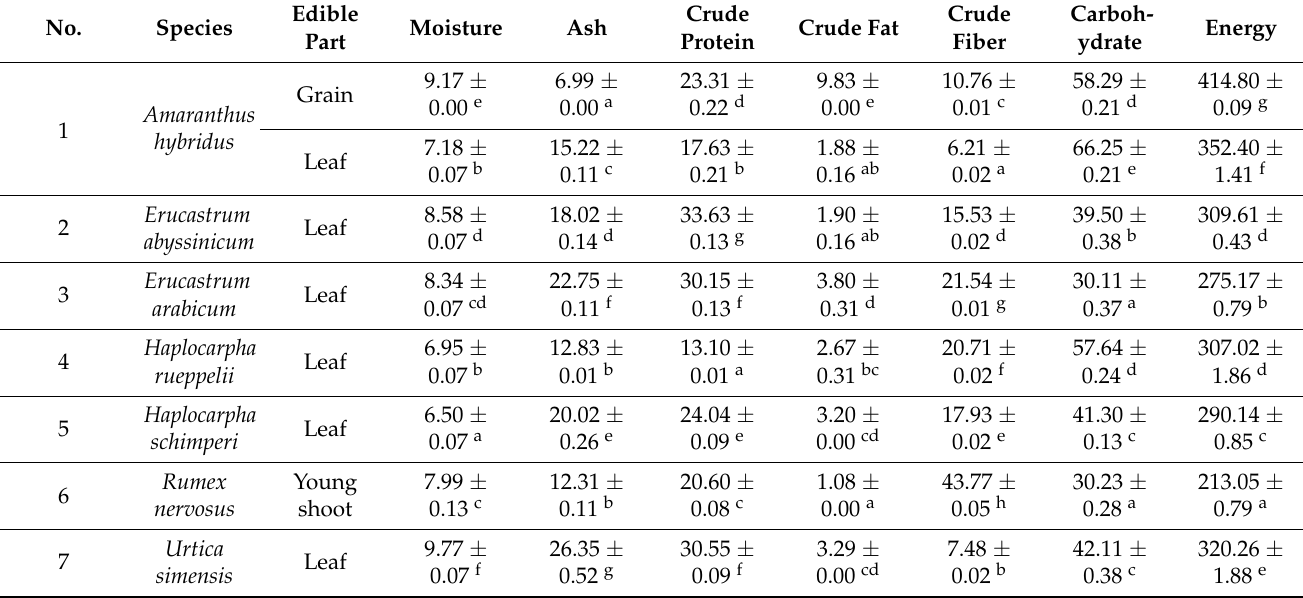
Table 1. Proximate contents of selected WEPs (g/100 g